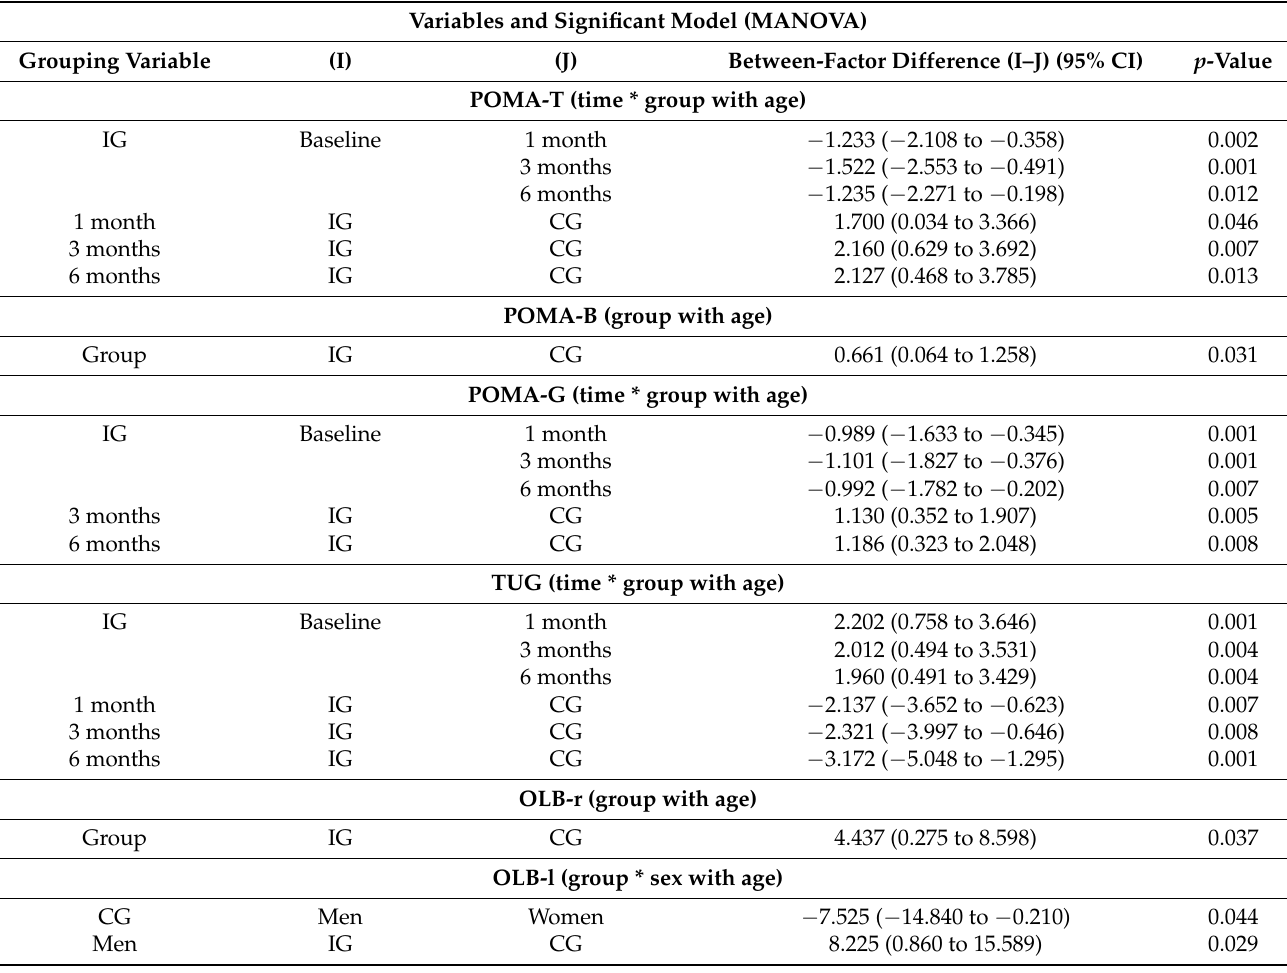
Table 4. Pair-wise comparisons using Šid á k post hoc test (MANOVA) in physical function variables. Only statistically significant differences in the comparisons of the significant MANOVA interaction models are shown. Variables and Significant Model